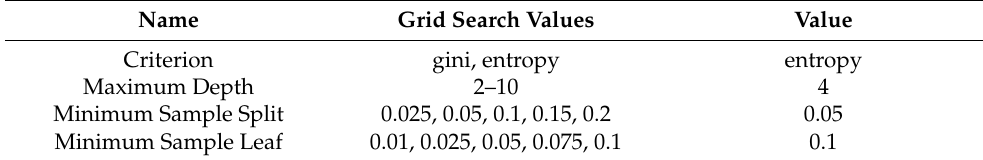
Table 5. Parameters for Decision Tree Training.